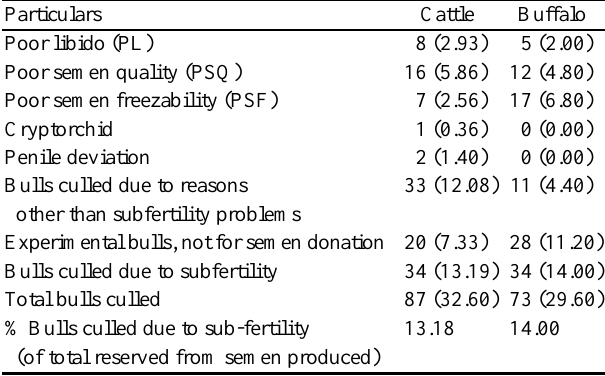
Table 3. Incidence of subfertility leading to disposal of bulls due to subfertility problems Particulars